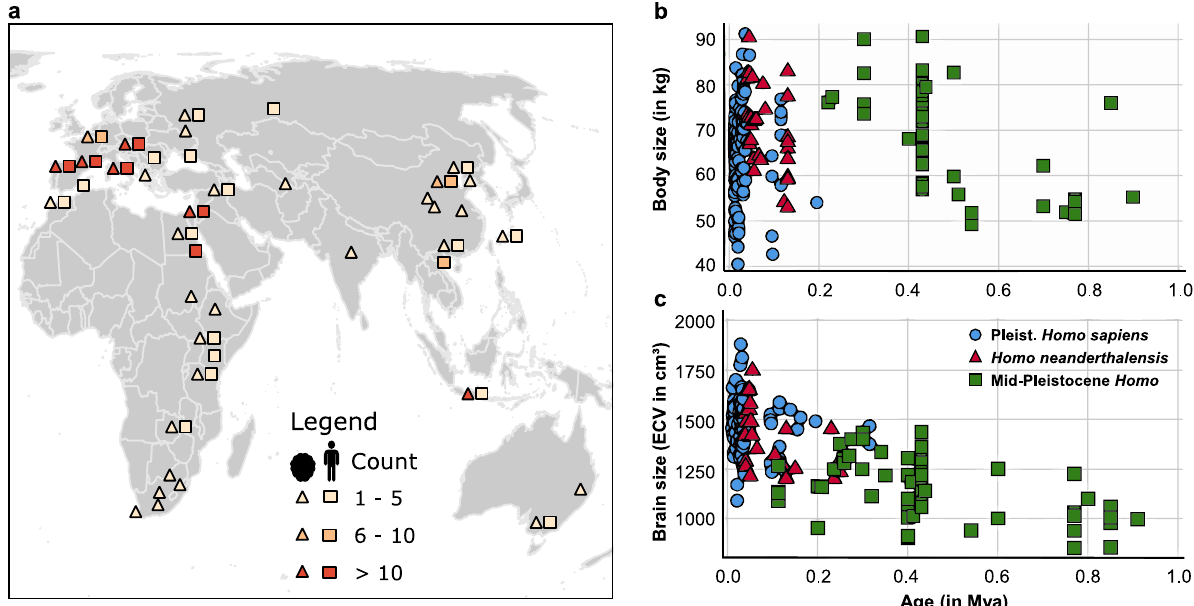
Fig. 1 Overview of body and brain size datasets for Homo used in this study. a Location and sample size ( n ) of body (squares) and brain size (triangles) estimates for individual Homo fossils used in this study (exact locations per specimen can be found in interactive webmap in Supplementary Note 1). b Time series for individual body size estimates ( n = 204) with taxonomic attribution; c time series for individual brain size ( n = 166) estimates with taxonomic attribution. Source data are provided in Supplementary Data 1 and 2.